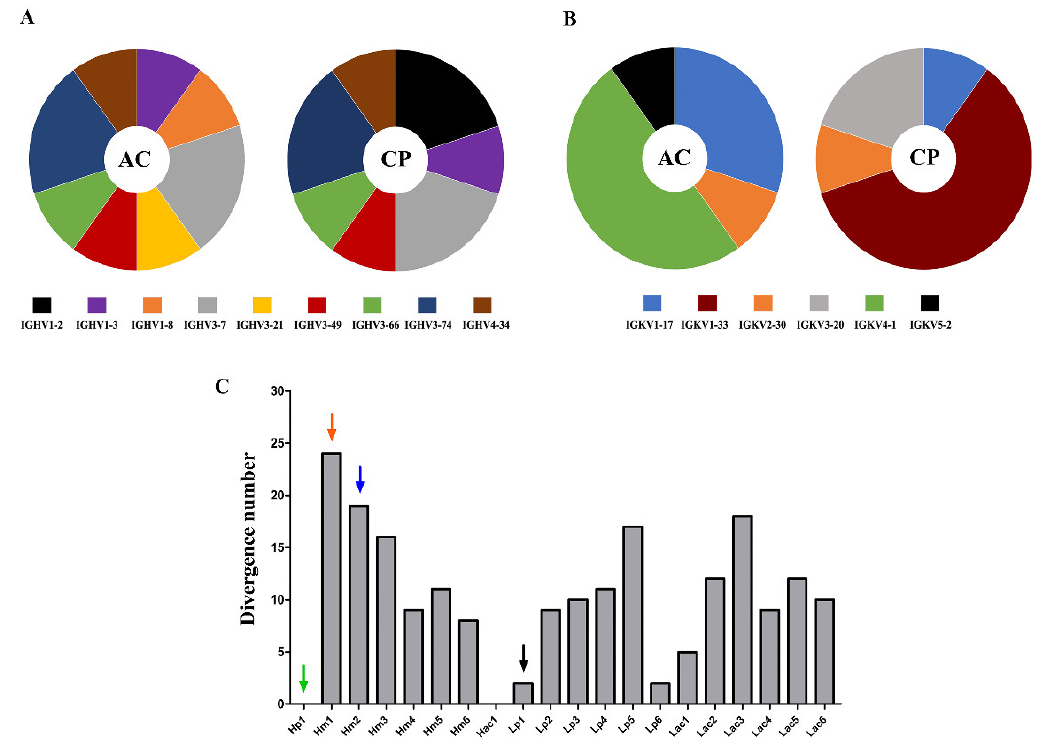
Figure 2. Differences between the most enriched sequences in both selection procedures. Repre- sentativeness of the V gene segment families to which the 10 most enriched VH ( A ) and VL ( B ) sequences belong, in acid (AC) and competitive selection (CP). The width of each slice of the graph is proportional to the number of sequences belonging to the specific gene family. ( C ) Analysis of the dissimilarity to germline V gene of the most enriched V domains. The degree of dissimilarity of the VH (H) and VL (L) comparing their closest germline sequences is represented by the number of non-identical residues. The arrows mark the three VH and the VL used in the tested scFv.